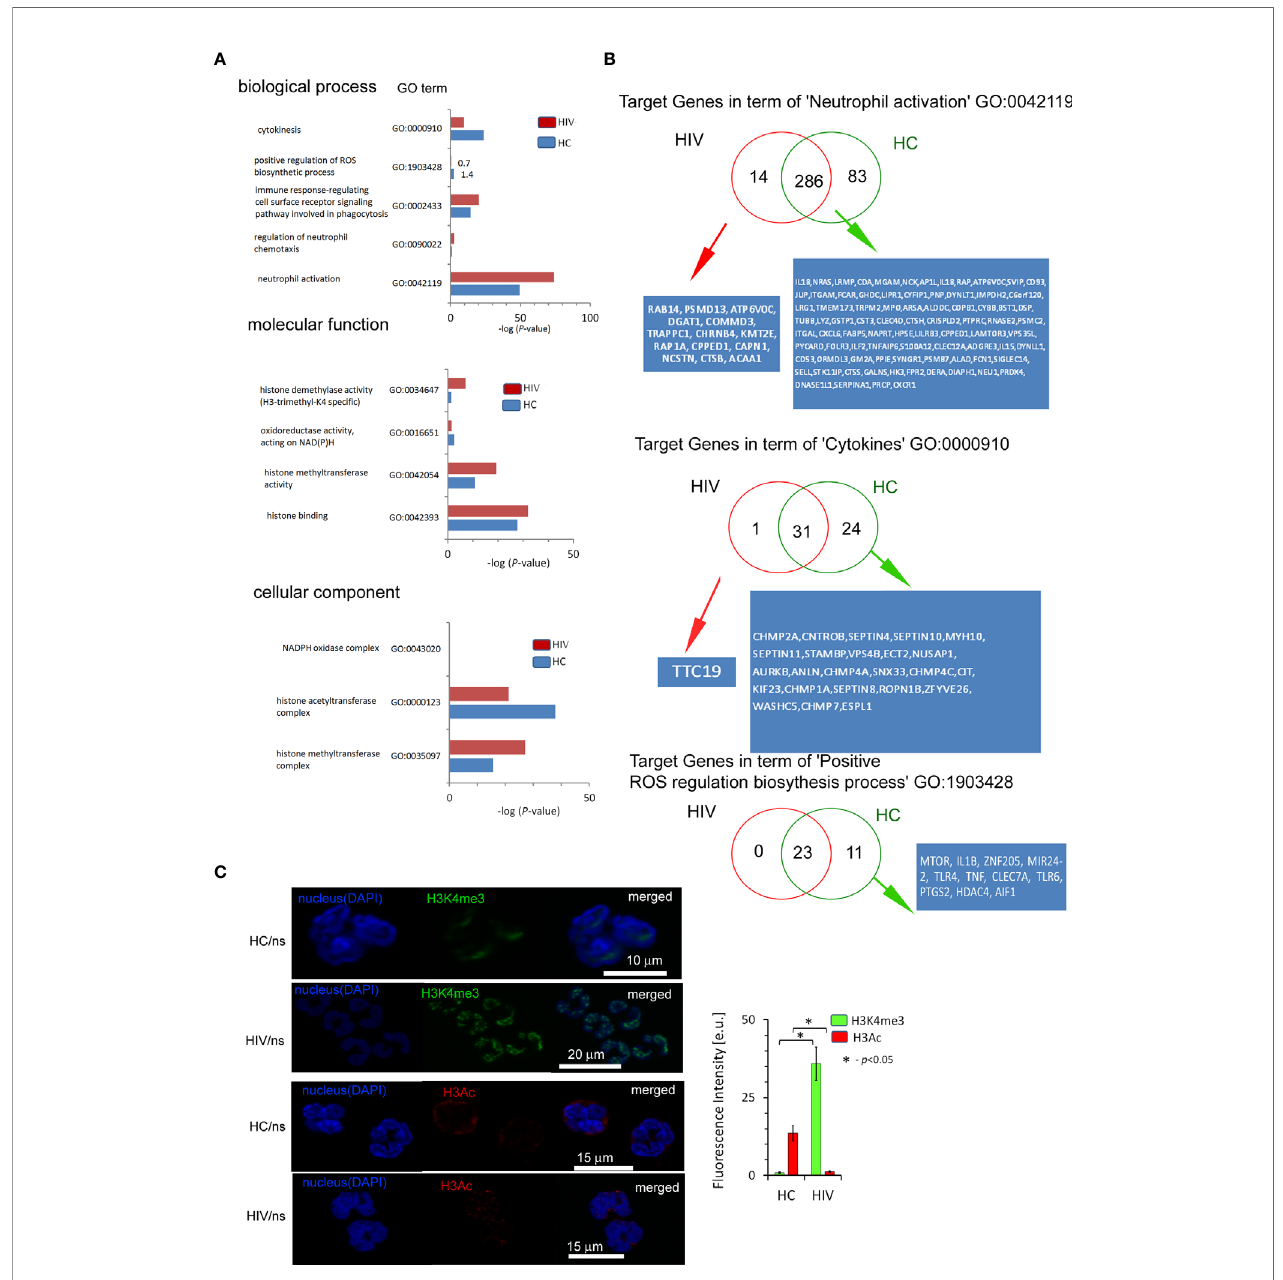
FIGURE 3 | The changes within the histone H3K4me3 affect principle processes responsible for antimicrobial functions of neutrophils in HIV-infected individuals. (A) A list of selected biological processes, molecular functions, and cellular components responsible for the ability to neutralize pathogens by neutrophils and in further posttranscriptional histone modi fi cations. The bars represent mean values for HCs (n=3) and HIV-infected individuals (n=3). The analysis of all Gene Ontology (GO) processes with statistic and FDR analysis are provided in the Supplementary Table S4 . (B) The analysis of target genes in the GO term ‘ Neutrophil activation ’ revealed 14 speci fi c genes in HIV individuals and 83 in HC. The analysis of target genes in the GO term ‘ Cytokines ’ revealed only speci fi c gene TTC19 for HIV. (C) The ICC analysis with double labeling for H3K4me3 (green pseudocolor) and H3Ac (red) con fi rmed GO fi ndings suggesting the increased methylation and decreased acetylation process within histone H3 in HIV-infected individuals. Nonspeci fi c fl uorescence (signal noise) was electronically diminished to the level when nonspeci fi c signal was undetectable (background). The bars represent average fl uorescence intensity ± SD calculated from four patients, using at least 100 single cells for each